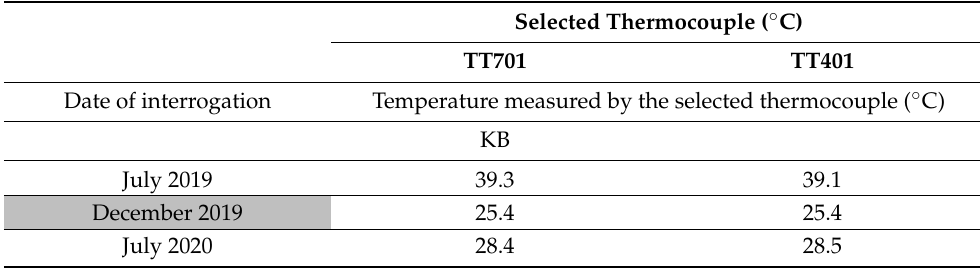
Table A2. Temperatures measured by selected thermocouples located near the surface of block KB at the different interrogation dates of the bonded DOFS instrumentation. Designation numbers of the thermocouples are the same as those presented in Figure 3. Greyed-out dates correspond to periods of immersion of the block in the